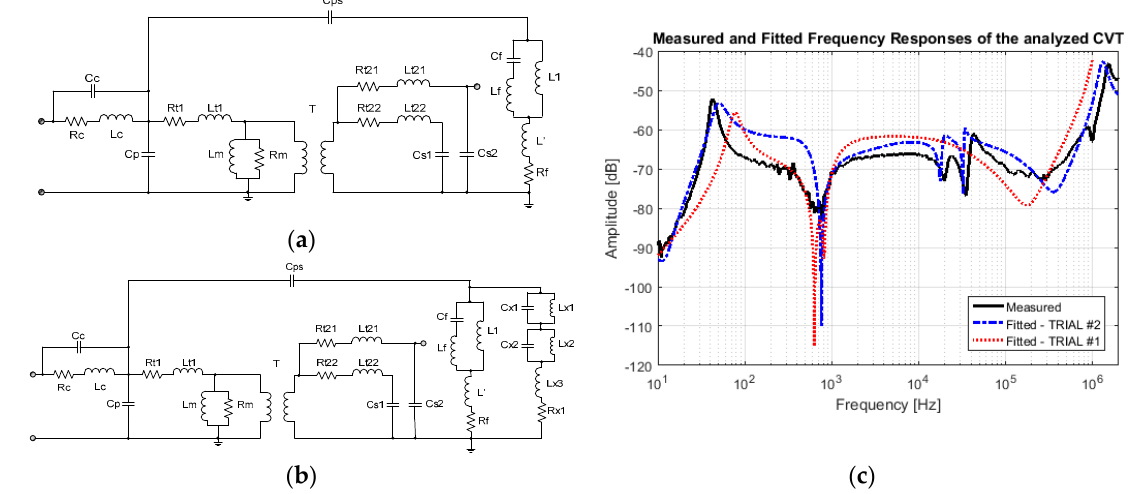
Figure 7. Equivalent circuit models used for the characterization of the CVT of interest: ( a ) Trial#1, ( b ) Trial#2, and ( c ) agreement of their responses with respect to the measured CVT SFRA spectrum.